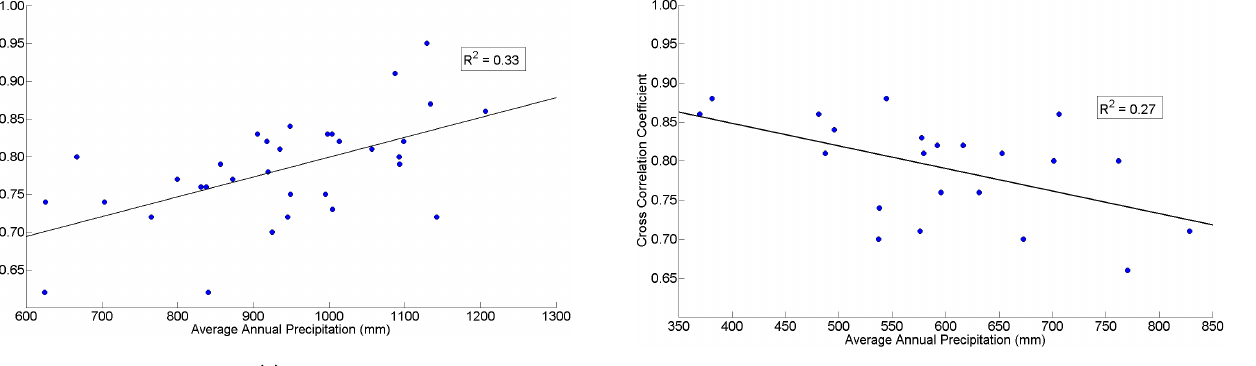
Figure 7. Peak cross correlation (r) between the 10 and 25 cm layers for all Nebraska sites Fig. 7. Peak cross correlation ( r ) between the 10 and 25cm layers versus the average annual precipitation. Each point represents one site. for all Nebraska sites versus the average annual precipitation. Each point represents one